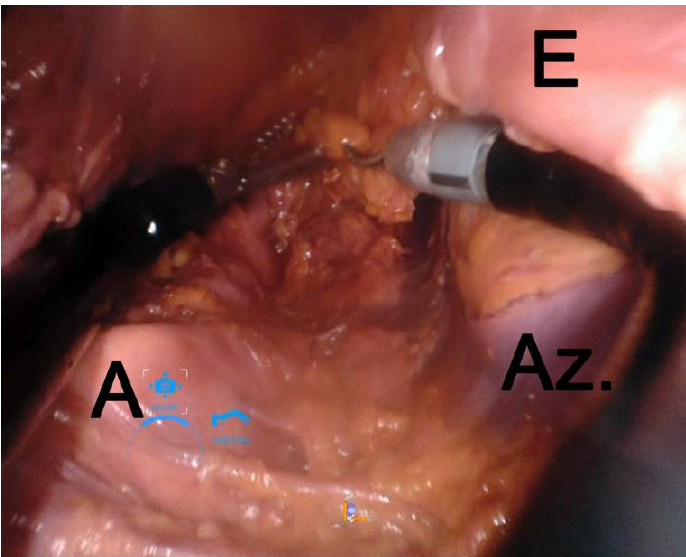
Figure 5. Da Vinci SP approach into the mid and lower mediastinum; esophagus (E); azygos vein (Az.); aorta (A).